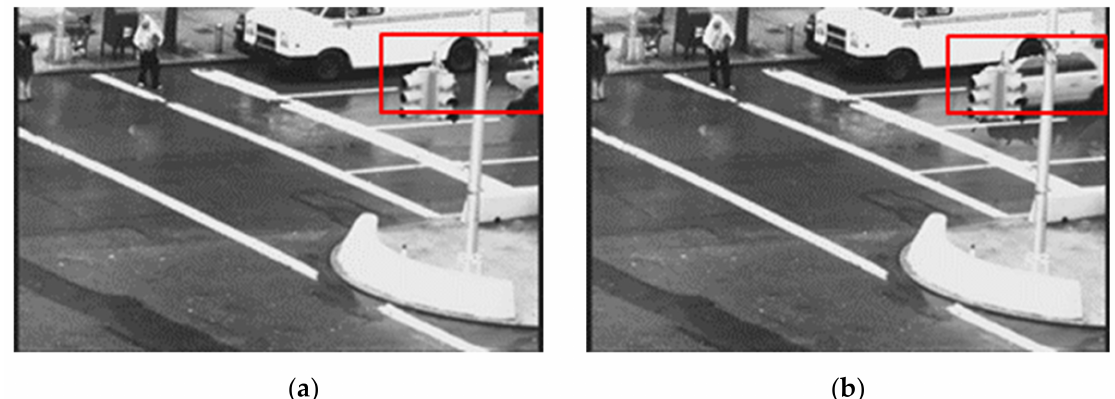
Figure 6. ( a ) The effect (see red rectangle marked area) of the different frame rates on TA output with a constant value of threshold of TA modelling on the “Traffic” video sequence. TA output: ( a ) At frame rate 12 fps and ( b ) At frame rate 24 fps.